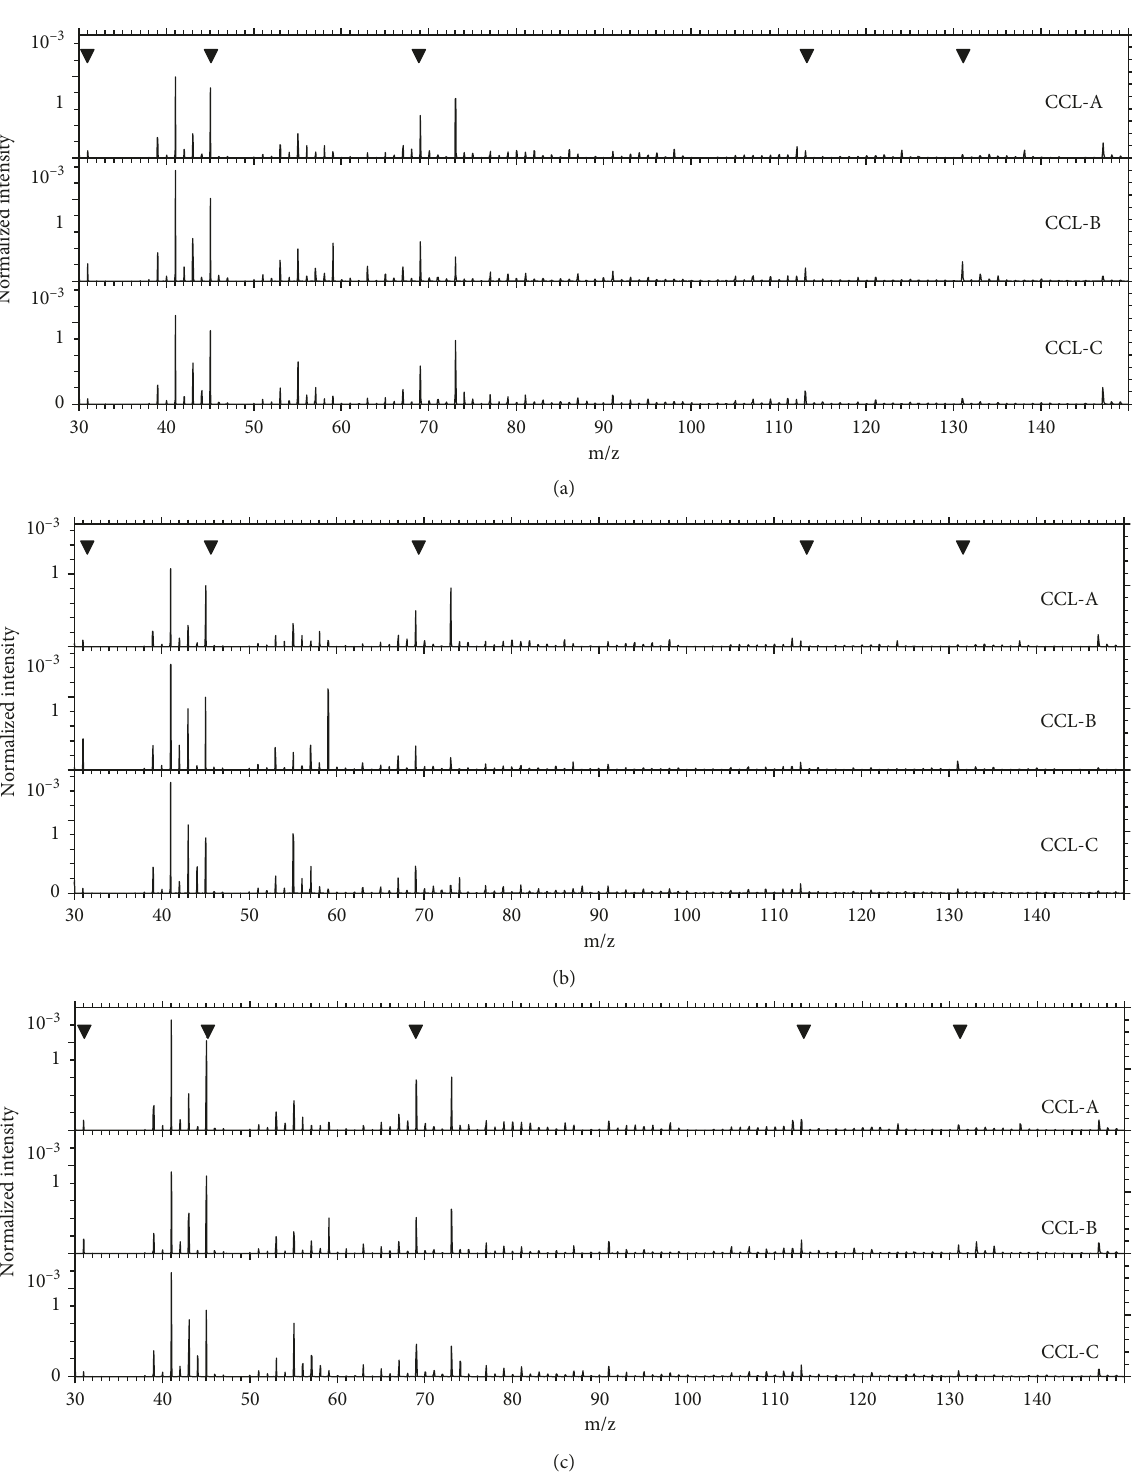
Figure 4: Positive-ion ToF-SIMS spectra of cosmetic contact lens revealed the presence of the bulk polymer PHEMA at all surfaces of three lenses. (a) Noncolored part: (1) central clear zone. (b) Colored part: (2) front surface. (c) Colored part: (3) back